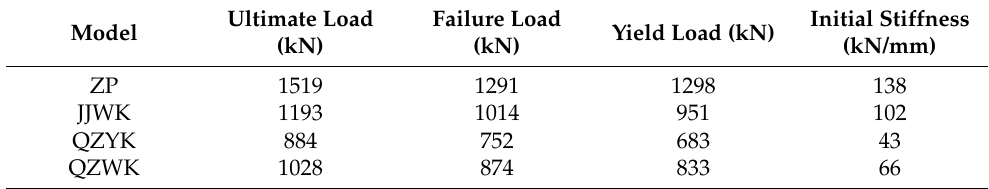
Figure 19. Load–displacement skeleton curves of each model for comparison. Figure 19. Load – displacement skeleton curves of each model for comparison. Table 8. Characteristic indexes given by load–displacement skeleton curves for each Table 8. Characteristic indexes given by load – displacement skeleton curves for each model.